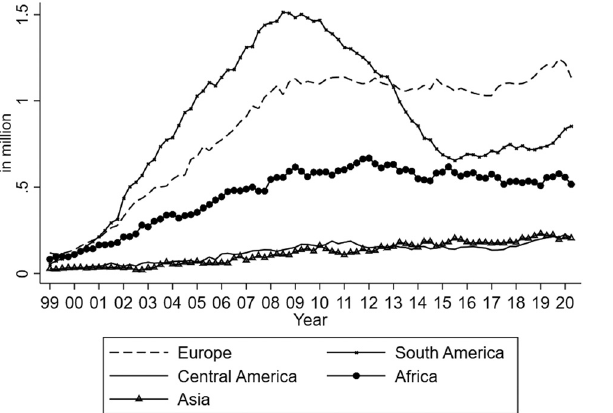
Figure A14: Stock of immigrant workers by region of country. Source: Spanish Labour Force